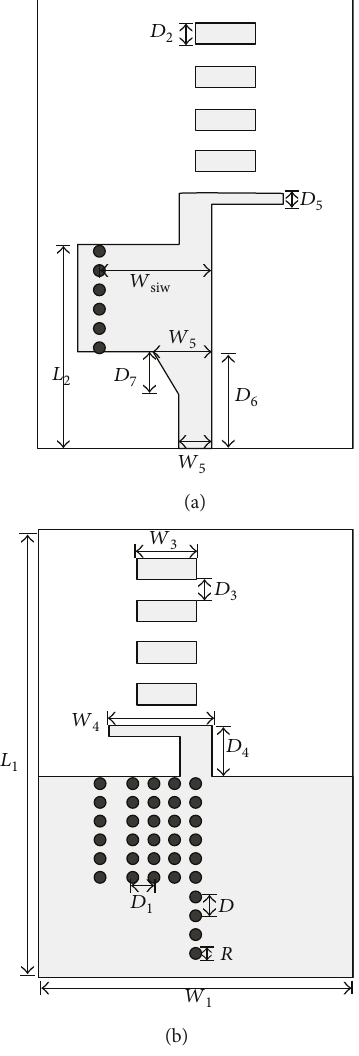
Figure 5: Layout of the proposed slow-wave half-mode substrate- integrated waveguide Yagi antenna designed on Rogers 4350 substrate. (a) Top view; (b) bottom